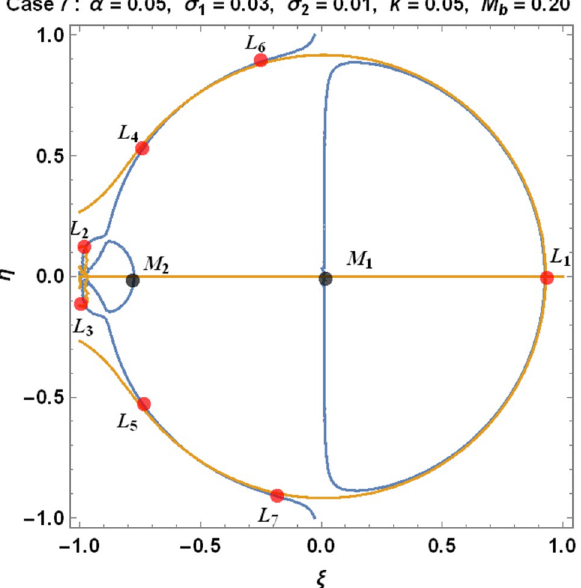
Figure 8. Effects of oblateness, Eccentricity of the orbits, semi-major axis, Albedo parameters, triaxiality, and the potential due to belt on the triangular libration points for the Earth–Moon system using case 7 of Table 4.